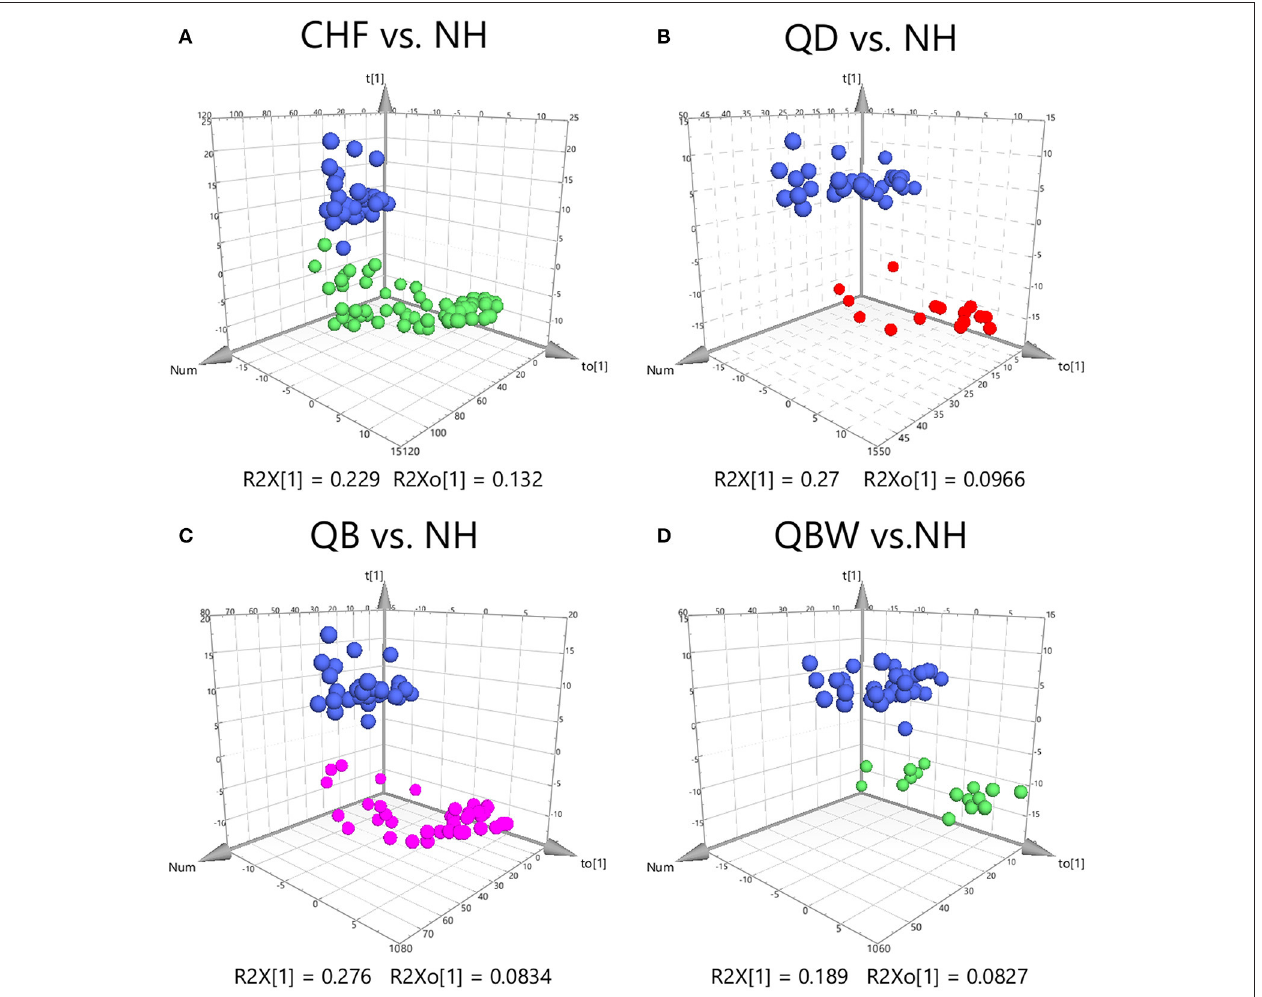
FIGURE 2 | OPLS-DA Score Plots among CHF, QD, QB, QBW, and NH. OPLS-DA Score Plots compared (A) CHF vs. NH, (B) QD vs. NH, (C) QB vs. NH, and (D) QBW vs. NH. CHF, Chronic heart failure; NH, Normal healthy group; QD, Qi deficiency group; QB, Qi deficiency and Blood stasis group; QBW, Qi deficiency and Blood stasis and Water retention